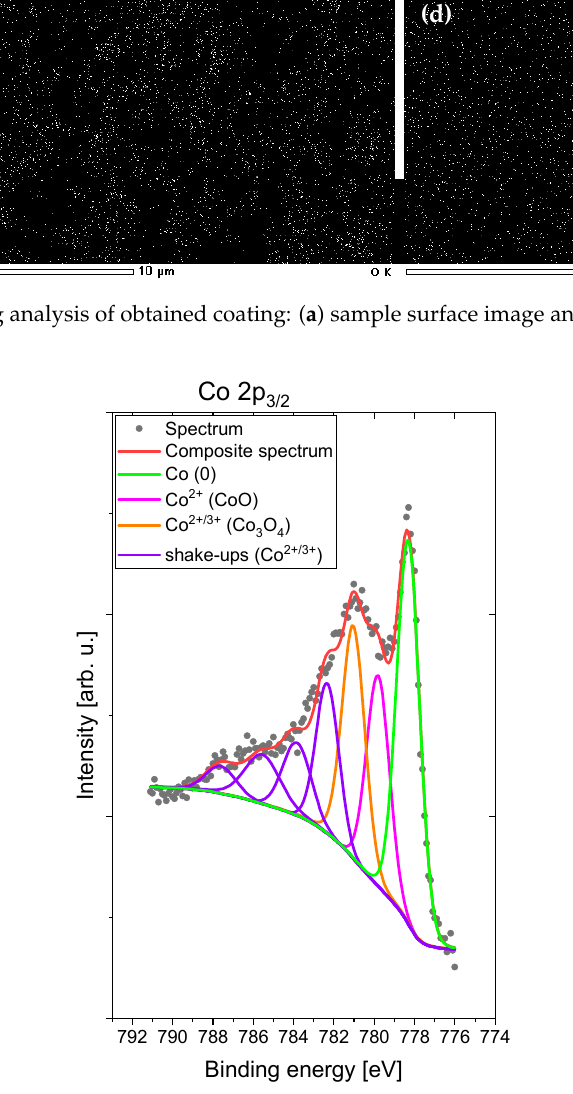
Figure 12. XPS spectrum of sample obtained by one-step method B.